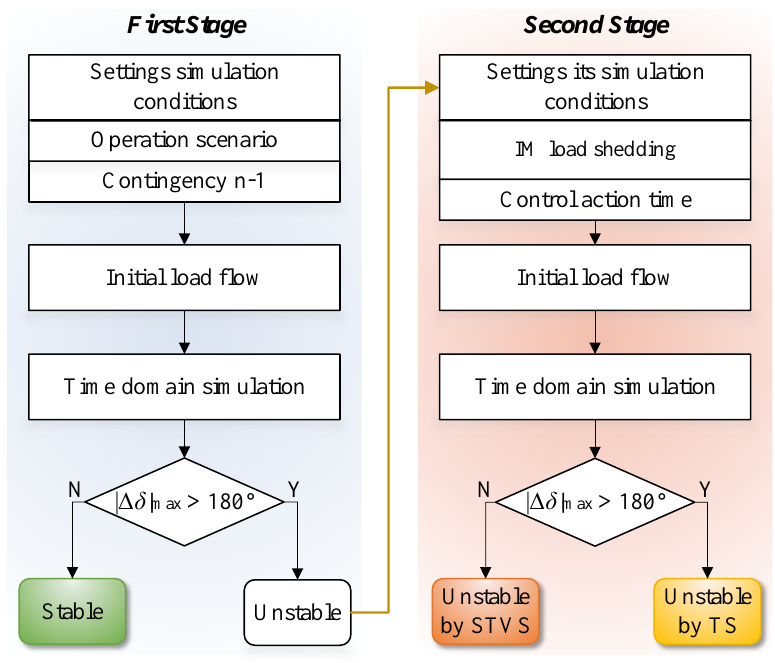
Figure 7. Flowchart of the defined STSS labeling.